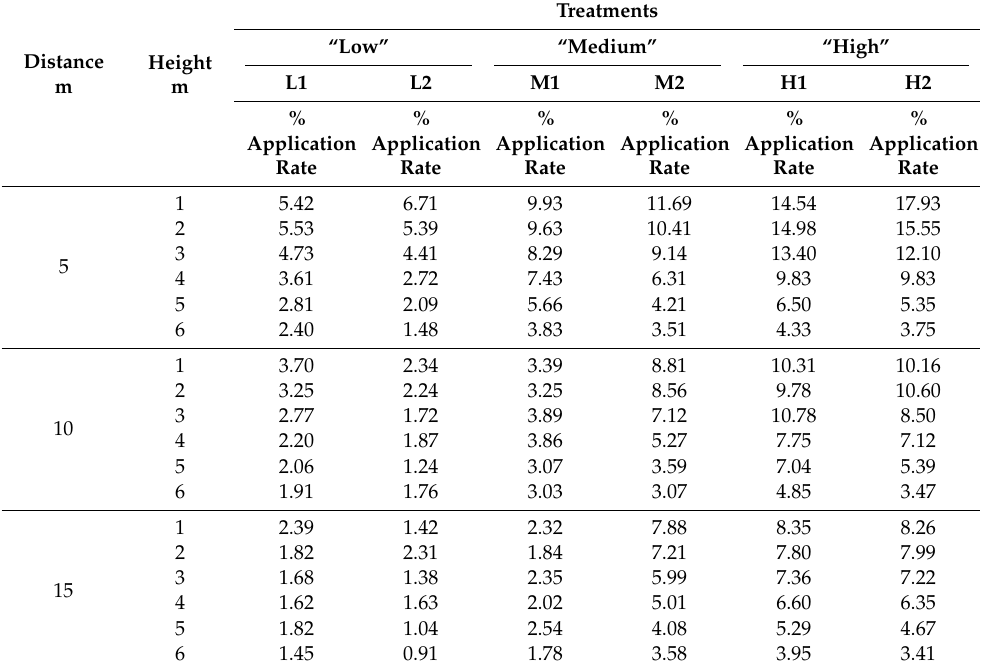
Table 7. Airborne spray drift deposition.